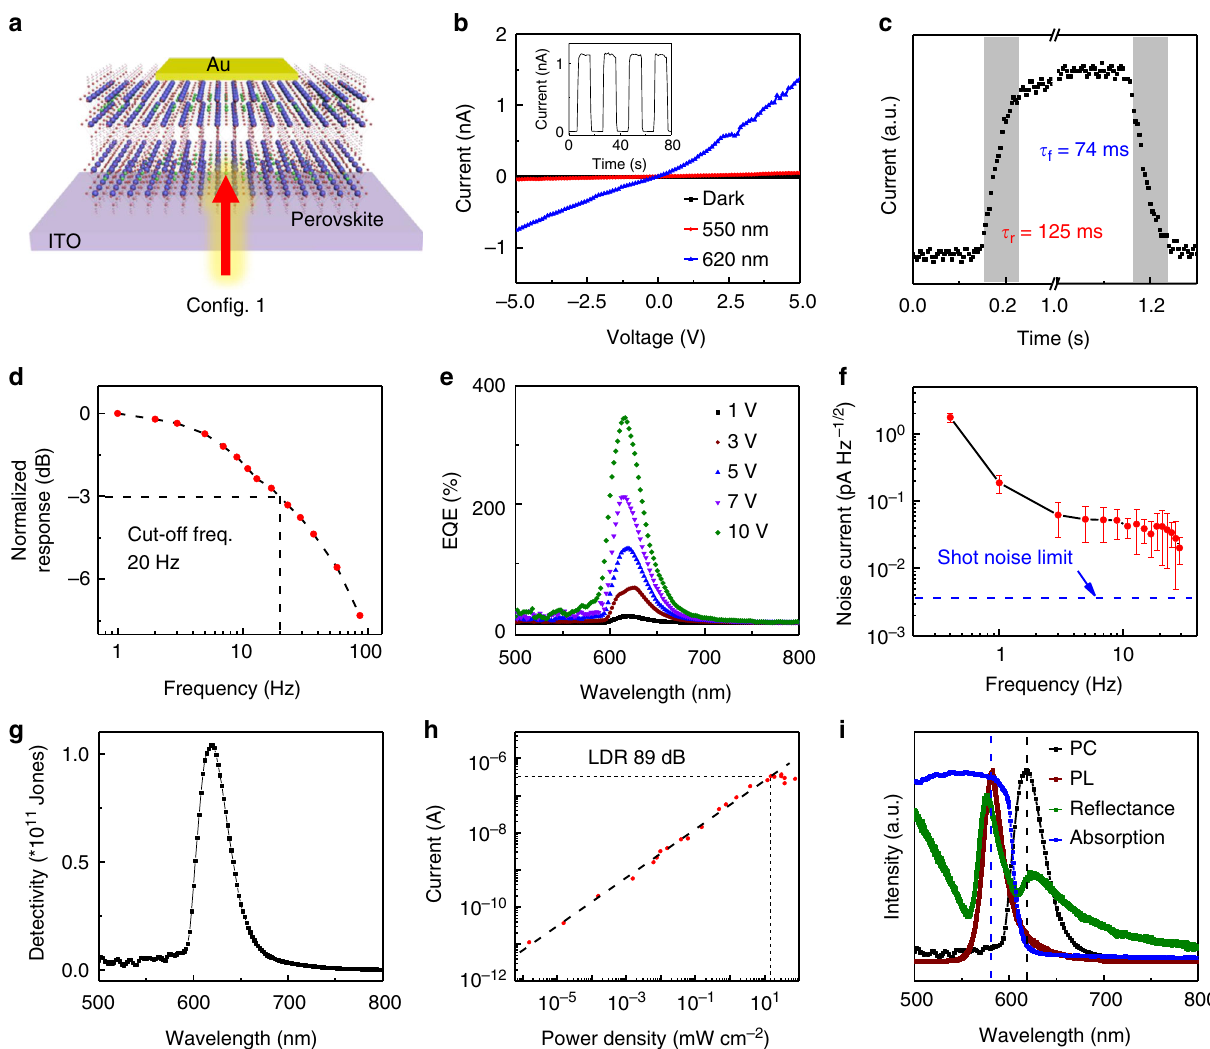
Fig. 2 Narrowband photodetection based on (BA) 2 (MA)Pb 2 I 7 single-crystal plates. a Schematic of the 2D perovskite-based vertical device illuminated from back side (denoted as Con fi g. 1). b Dark current and photocurrent of an 80 μ m-thick (BA) 2 (MA)Pb 2 I 7 detector under a 550nm monochromatic light with a power density of 5 μ W cm − 2 (or a 620 nm monochromatic light with a power density of 20 μ W cm − 2 ). Inset: the optical switching characteristic of the device under a 620 nm monochromatic light illumination with a power density of 20 μ W cm − 2 at a bias of 5 V. c Temporal response of the (BA) 2 (MA) Pb 2 I 7 device. d Normalized response as a function of modulation frequency. The 3 dB cutoff frequency is around 20 Hz. e EQE spectra of the (BA) 2 (MA) Pb 2 I 7 device under different biases. f Average total noise measured by lock-in ampli fi er and preampli fi er under a bias of 5 V and calculated shot noise limit (blue dash line). Error bars are the SDs at each frequency. g Speci fi c detectivity (D*) spectrum under a bias of 5 V with a modulation frequency of 5 Hz. h Linear dynamic range of the detector under a bias of 5 V. i Normalized photoconductivity (PC), photoluminescence (PL), re fl ectance, and absorption spectra of the (BA) 2 (MA)Pb 2 I 7